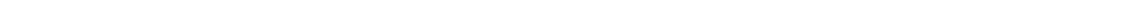
Fig. 1 IDH1-R132H-mutated cells are more susceptible to treatment with ABT263. a U87MG glioblastoma cells were transduced with pLPCX IDH1-WT or IDH1-R132H prior to treatment with increasing concentrations of ABT263 for 72 h. Cellular viability was determined by MTT assay and the IC 50 -values were calculated based on a non-linear regression analysis. Data are presented as mean and SD, n = 3. b T98G glioblastoma cells were transduced with pLPCX IDH1-WT or IDH1-R132H prior to treatment with increasing concentrations of ABT263 for 72 h. Cellular viability was determined by MTT assay and IC 50 -values were calculated. Data are presented as mean and SD, n = 3. c HCT116 IDH1-WT/IDH1-R132H cells were treated with increasing